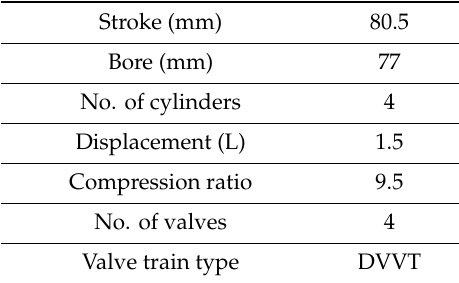
Table 3. Main dimensions of the base engine.